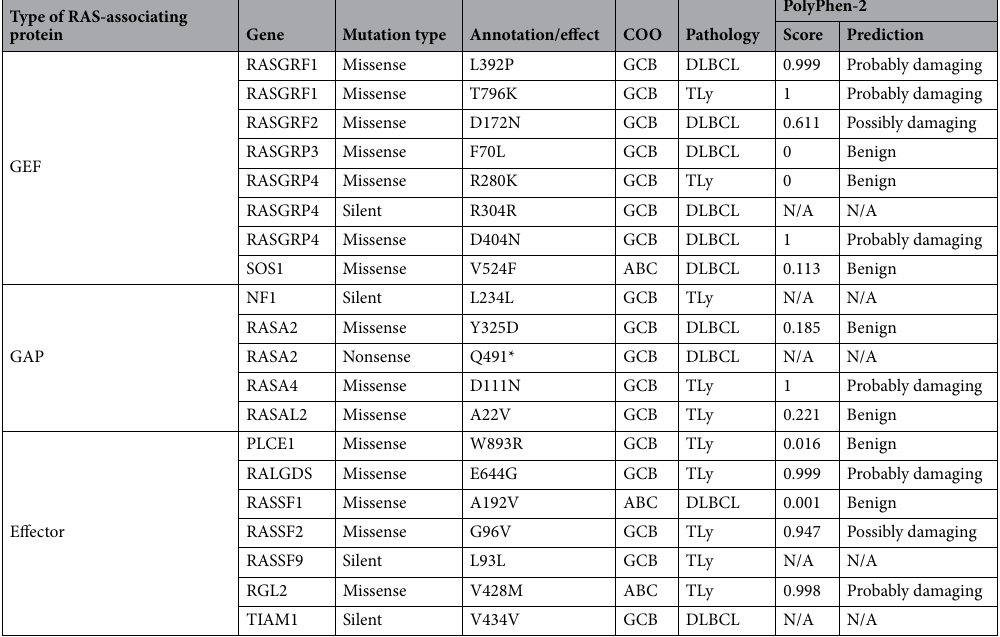
Table 1. In rrDLBCL and rrTLy samples, 20 mutations were found in 16 different genes encoding for a RAS- associating protein. The possible impact of the missense mutations on the structure and the function of the proteins was predicted with PolyPhen-2 software version 2.2. PolyPhen-2 classified a missense mutation as Probably damaging (more confident prediction), Possibly damaging (lower confident prediction) as Benign based on a False Positive Rate 27